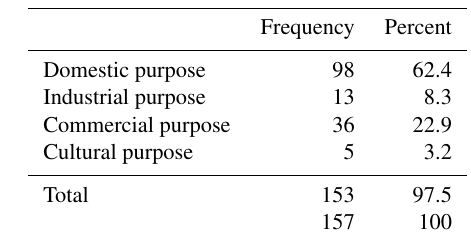
Table 2. Purpose of the Water in the Dam.